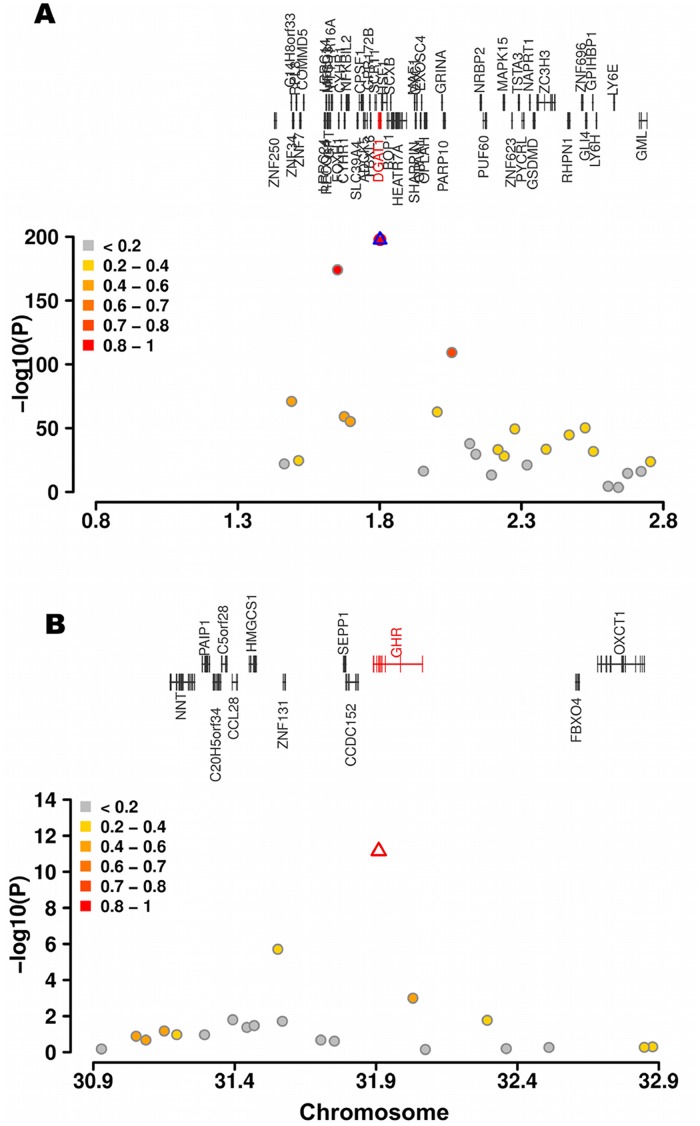
Detailed view of two genomic regions within known QTL for milk fat content in cattle.QTL regions on BTA14 (A) and BTA20 (B) encompassing DGAT1 and GHR, respectively. Open symbols (blue and red triangles) represent the K232A- and the F279Y-substitution, respectively. Different colors indicate the extent of linkage disequilibrium (r2) between the postulated QTN and all other SNPs.